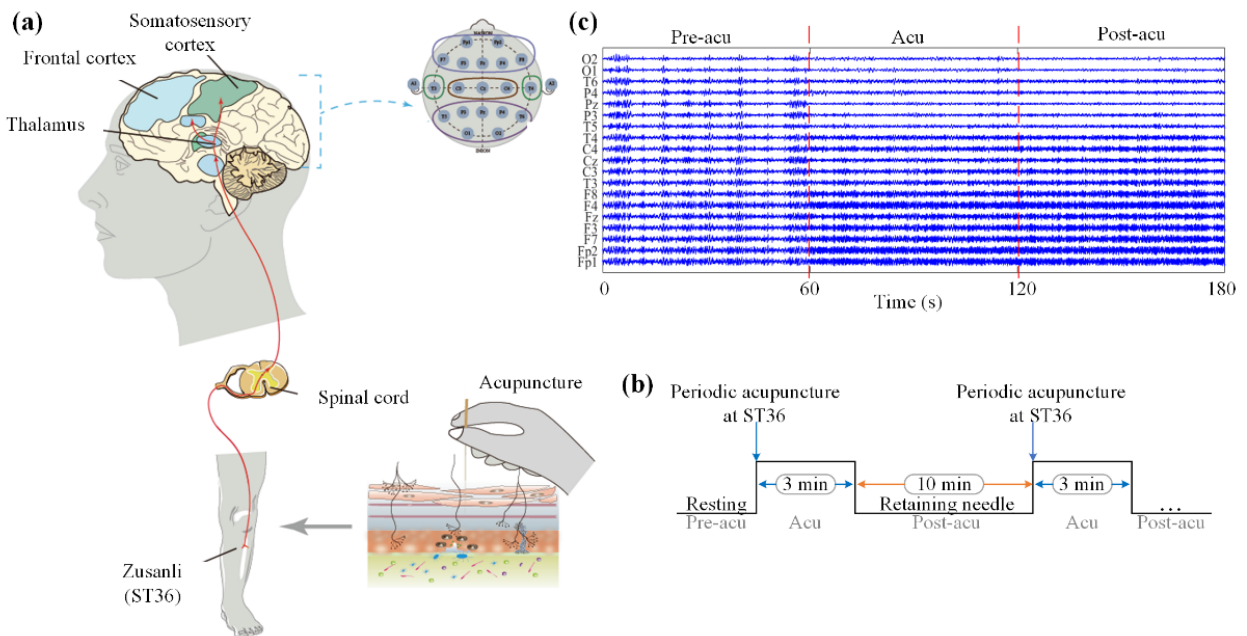
Figure 1. The schematic diagram of the experimental operation. ( a ) Schematic diagram of the acupuncture experiment. Electroencephalographic signals evoked by manual acupuncture at the ST36 acupoint of healthy subjects were directly recorded in three states: pre-acupuncture, acupuncture, and post-acupuncture. ( b ) A timeline of the detailed experimental procedure of manual acupuncture manipulation and ( c ) the EEG signals recorded.